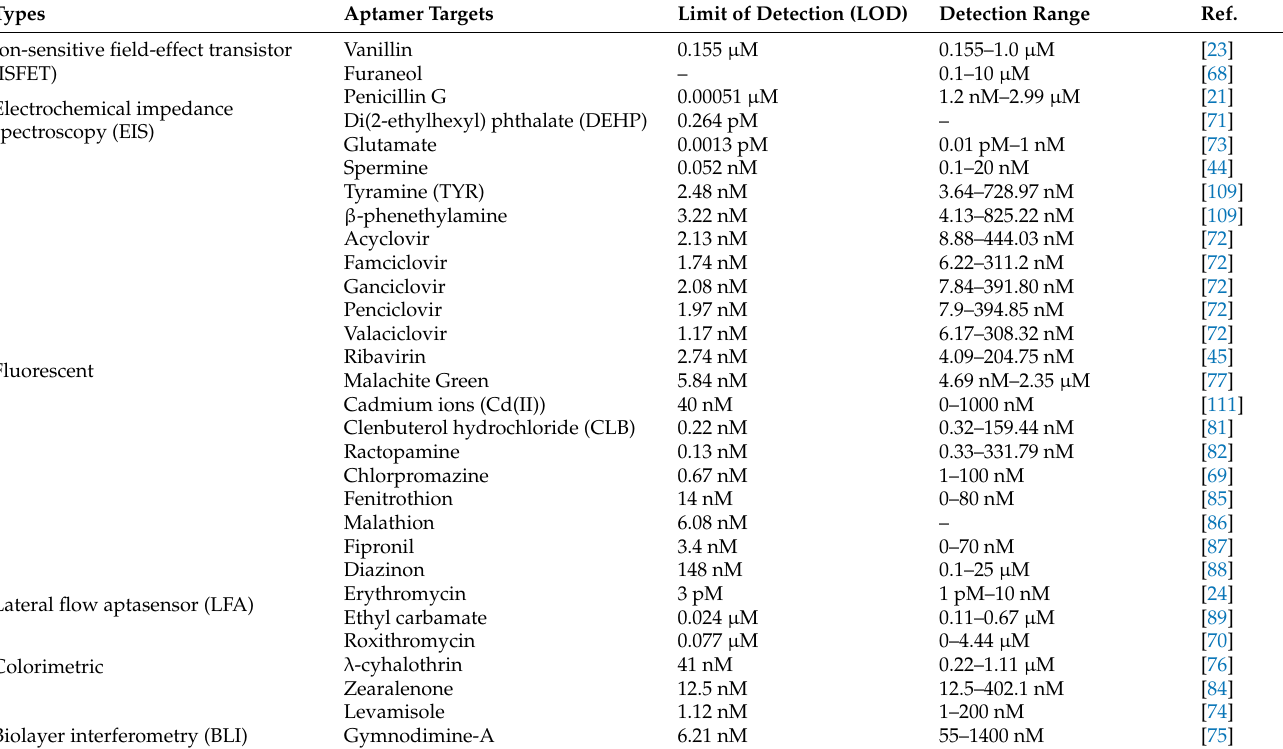
Table 2. Representative biosensors using aptamers against small molecule contaminants that are generated from